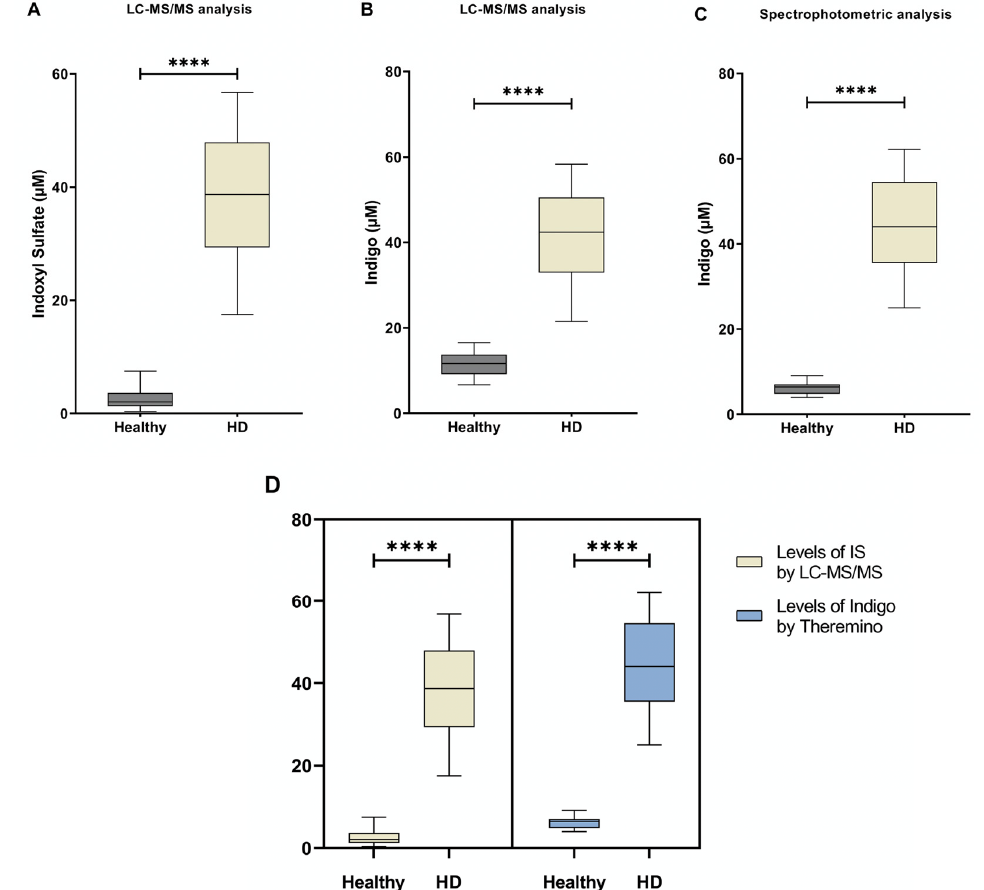
Figure 3. The level of IS and Indigo blue measured by LC-MS/MS and Theremino. ( A ) Differences between IS concentrations obtained in the two groups by using the standard LC-MS/MS approach. ( B ) Differences in Indigo levels between groups obtained by LC-MS/MS. ( C ) Differences in Indigo levels obtained by Theremino. ( D ) No differences were found in IS and Indigo levels among groups obtained by LC-MS/MS and a Theremino spectrophotometer, respectively. **** p < 0.001. Abbreviation: HD, Hemodialysis; IS, indoxyl sulfate.